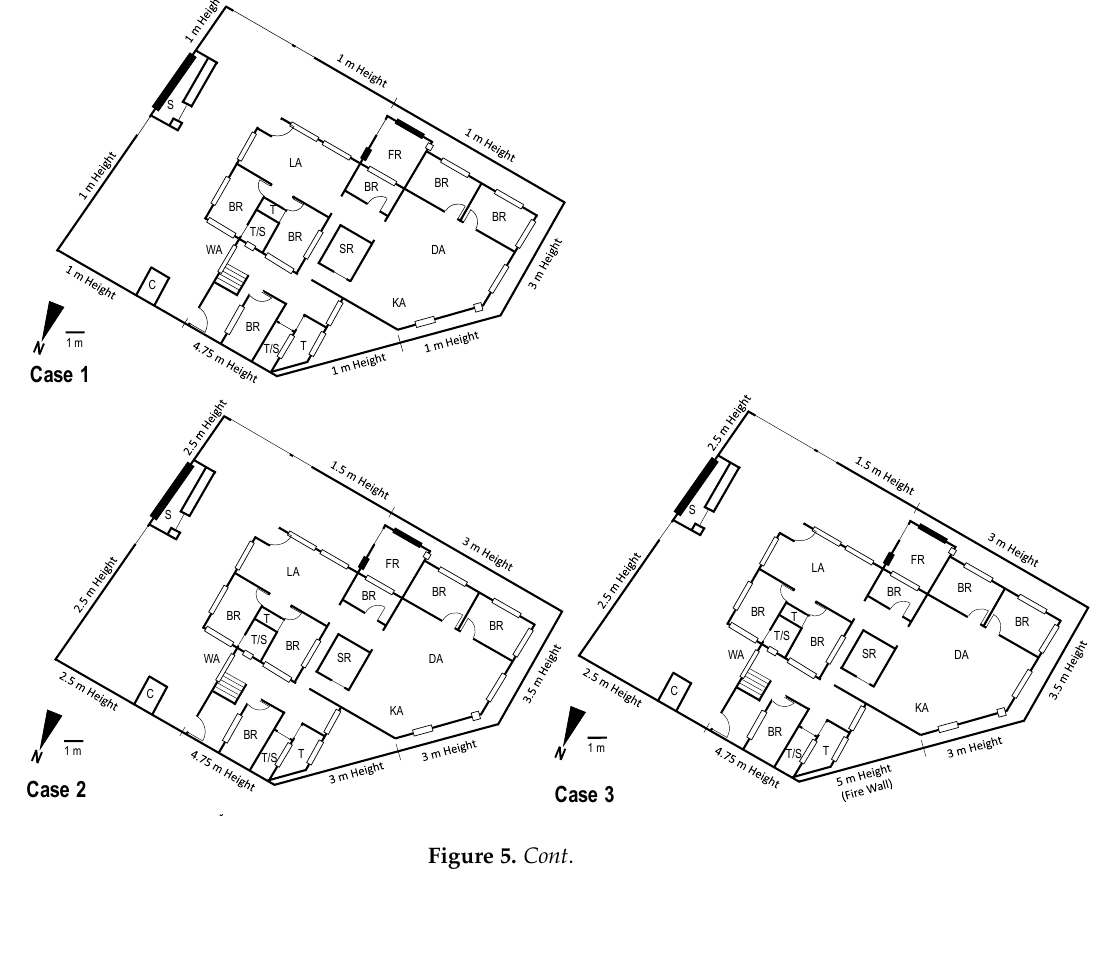
Figure 5. Simulation cases for the detached family house: Case ( 1 ) low lot perimeter wall (all windows and doors opened); Case ( 2 ) high lot perimeter wall (all windows and doors opened); Case ( 3 ) high lot perimeter wall with firewall (all windows and doors opened); Case ( 4 ) high lot perimeter wall and firewall (all windows and all internal doors opened); Case ( 5 ) high lot perimeter wall and firewall (all windows opened and all doors closed); Case ( 6 ) high lot perimeter wall and firewall with left lot perimeter wall opened (all windows and doors opened), and; Case ( 7 ): high lot perimeter wall and firewall with left lot perimeter wall opened (all windows opened and all doors closed).